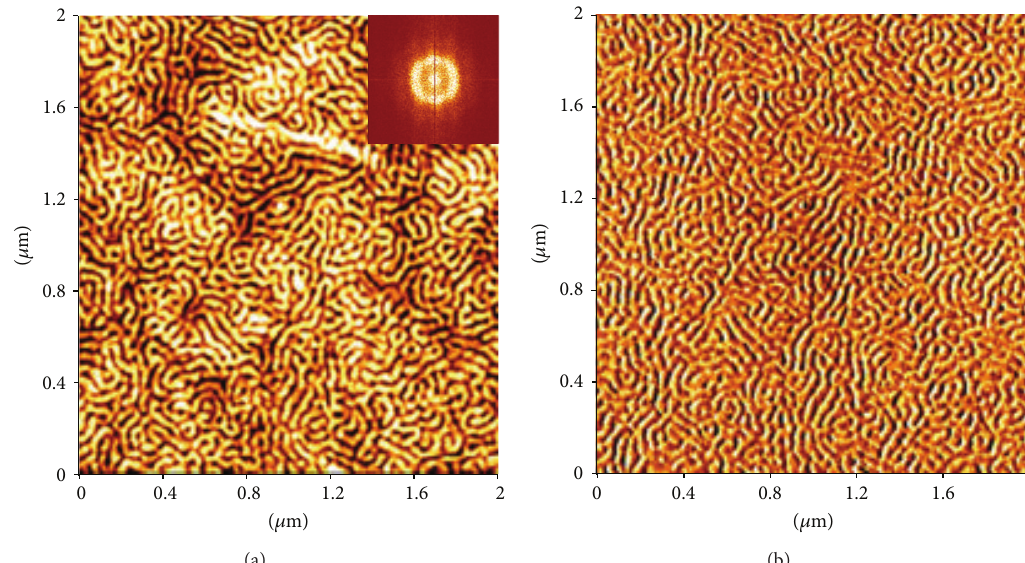
Figure 1: AFM topography (a) and phase (b) images of PS- b -PFS thin films on Si substrates prepared from 1.0 wt.% solution of the polymer in toluene prior to any